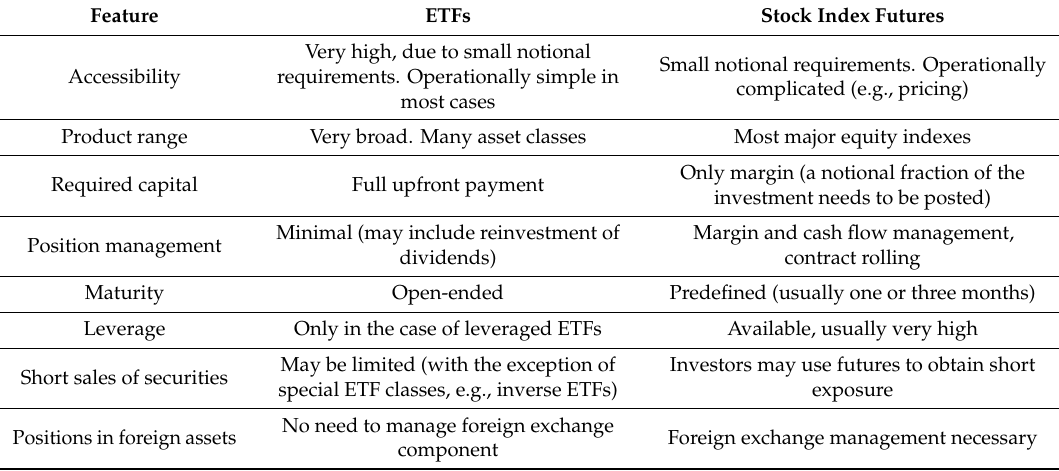
Table 1. Main di ff erences between ETFs and stock index futures. Own compilation based on Hamid and Edrosolan (2009), Madhavan et al. (2014), Arnold and Lesn é (2015), CME Group (2016), Madhavan (2016), Arunanondchai et al. (2019), Marszk et al.